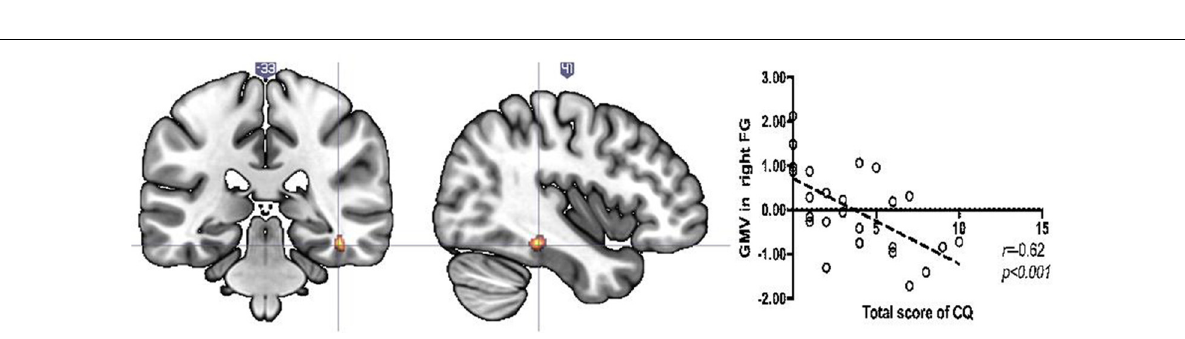
FIGURE 2 | Significant decrease in regional GMV related to childhood adversity (CA) score in right fusiform gyrus in the male sample. Scatterplot illustrates the relationship between CQ score and GMV (for display purposes only). The x -axis of the scatterplot represents standardized residuals of GMV and the y -axis represents the total score of CQ. For standardized residual measures, age and total intracranial volumes were regressed